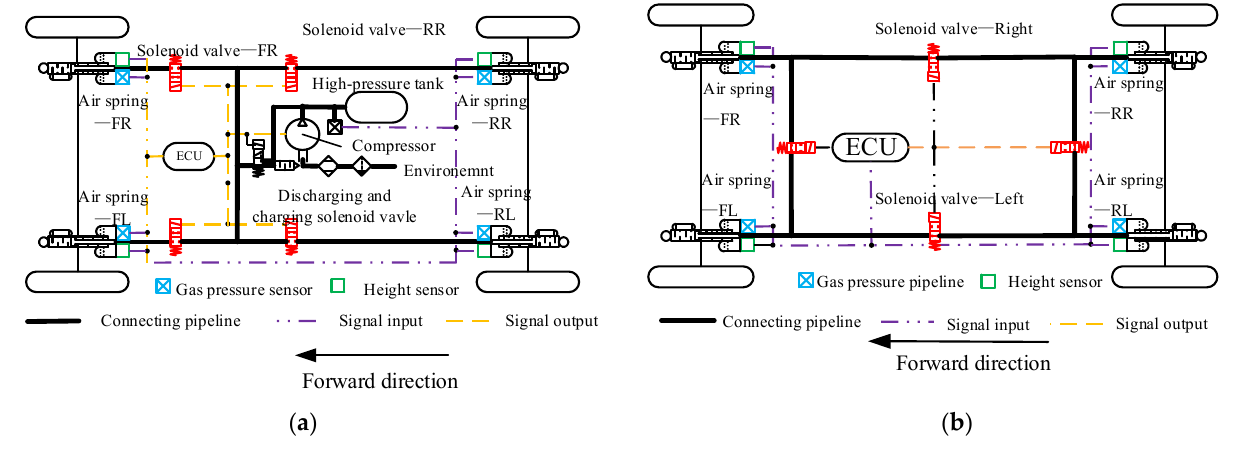
Figure 1. Interconnected air spring system configuration. ( a ) The configuration and working principle of outsourced mode activation. ( b ) The configuration and working principle of interconnected mode